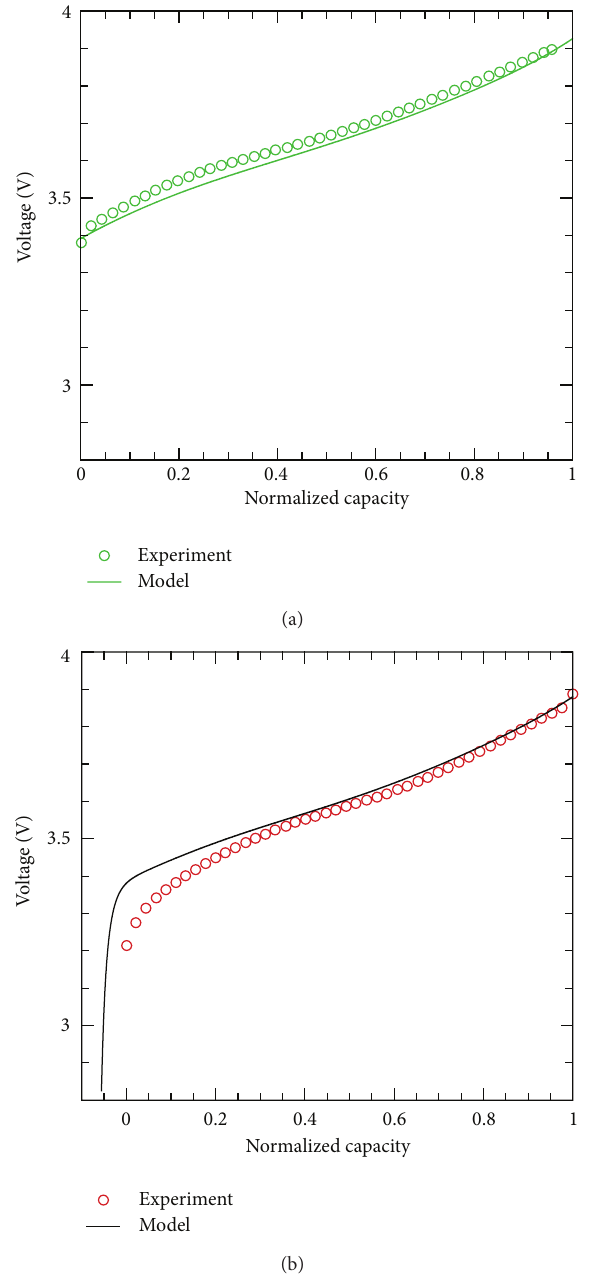
Figure 4: Computed cell voltage versus measured cell voltage for the entire charge-discharge cycle of a Li 𝑥 C 6 -Li 𝑦 Mn 2 O 4 battery with 1C charge/discharge rate: (a) charge, (b)